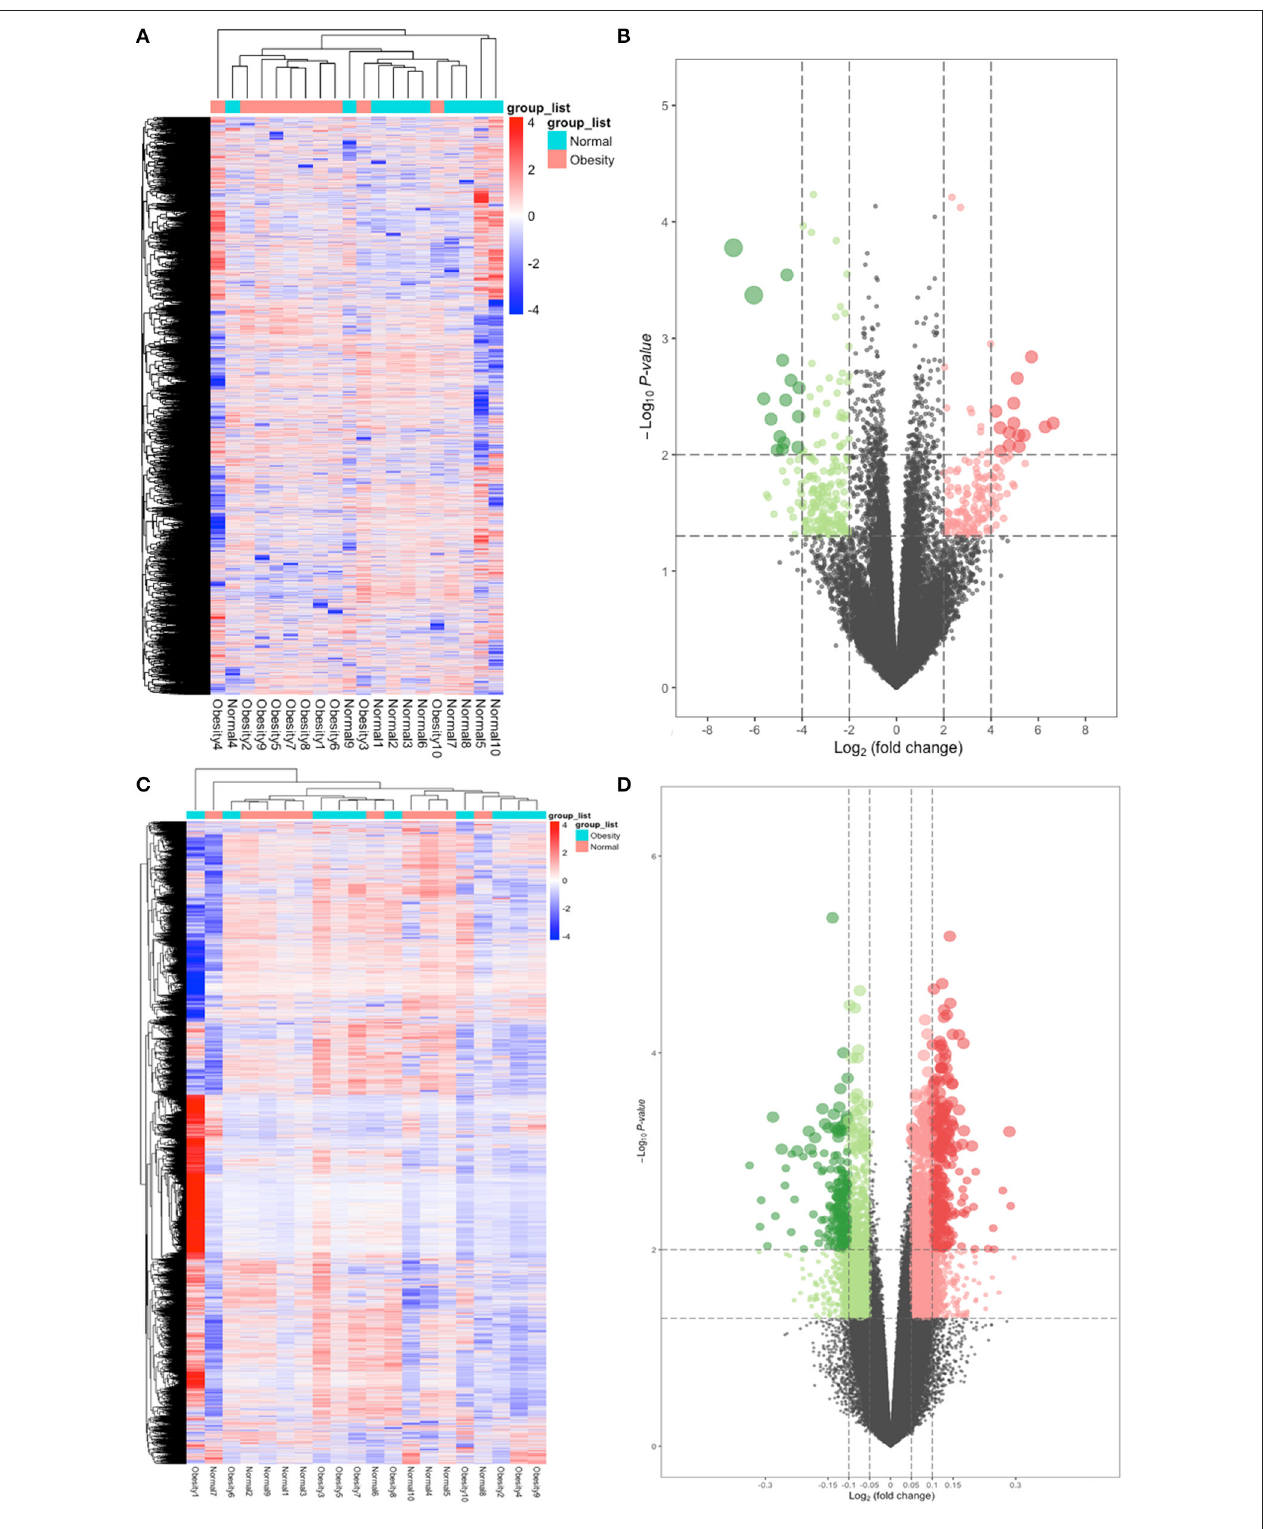
FIGURE 2 | Heatmap and volcano plots of differentially expressed genes (DEGs) and differentially methylated positions (DMPs). (A) Heatmap for DEGs. Obesity groups are in the red cluster, and normal samples are in the green cluster. (B) Volcano plot for DEGs. The two vertical lines are the 2-fold change boundaries, and the horizontal line is the statistical significance boundary ( P < 0.05). Red dots show upregulated genes, and green dots are downregulated genes. (C) Heatmap for DMPs. Obesity groups are in the green cluster, and normals are in the blue cluster. (D) Volcano plot for DMPs. The vertical lines are the 0.05-fold change boundaries, and the horizontal line is the statistical significance boundary ( P < 0.05). Upregulated DMPs are marked with red dots, and downregulated DMPs are marked with green dots.